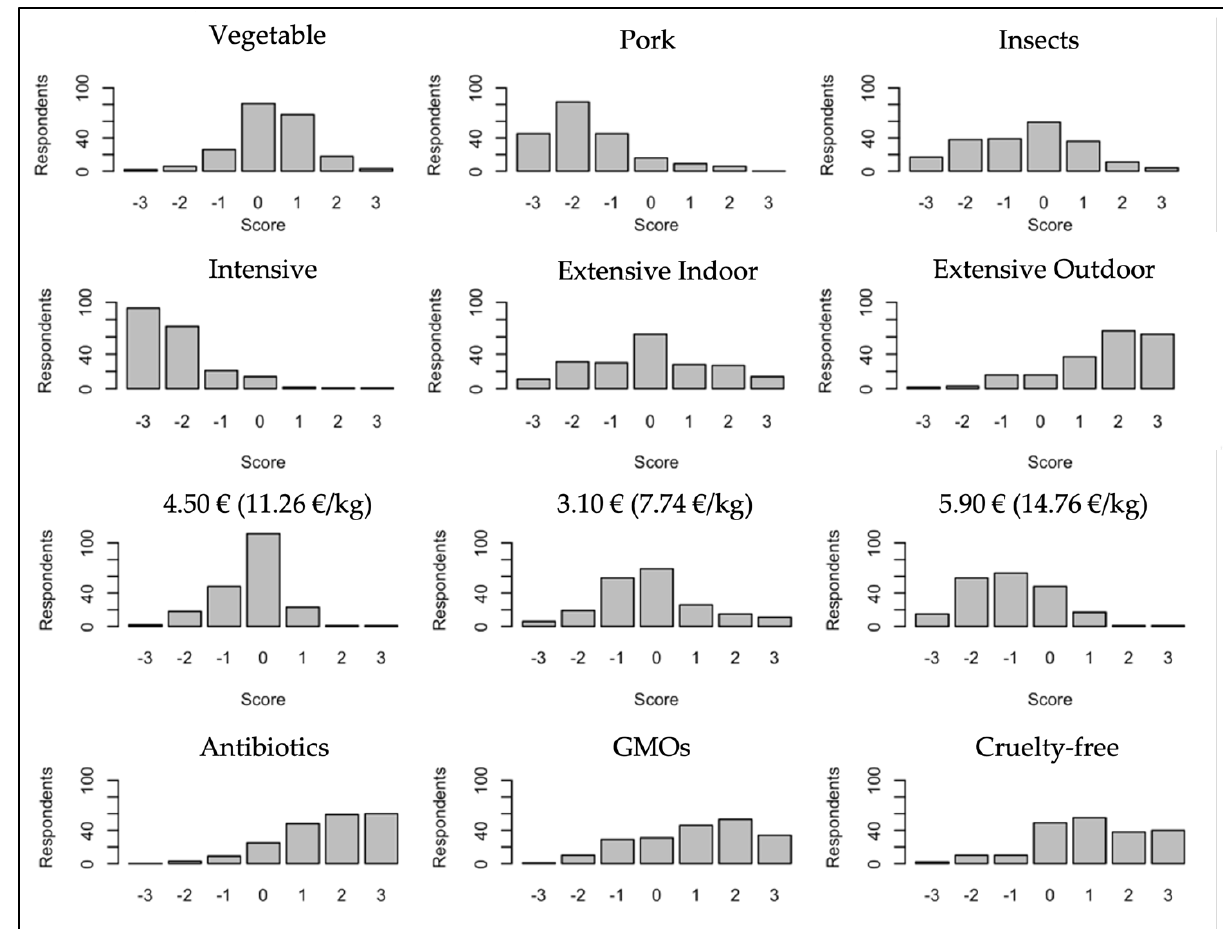
resultant sum of the % Level.